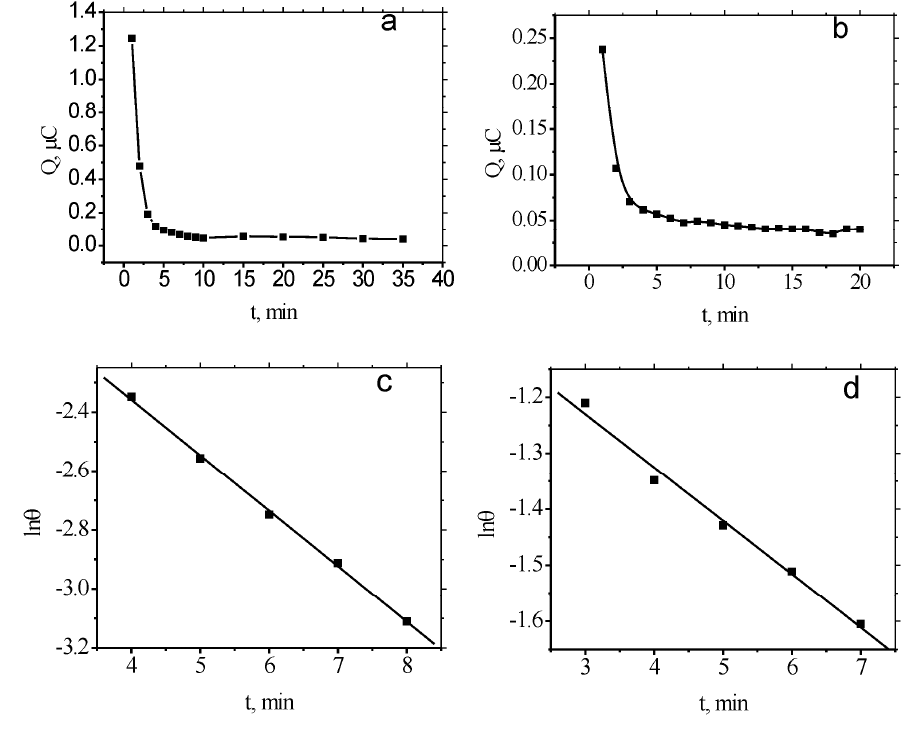
Figure 6. Integrated charge of the cathodic peaks from the CVs of ds-DNA/Au (a) and ss-DNA/Au (b) as a function of time after transfer to MB free E-buffer. Plot of ln( θ ) versus incubation time, from was determined, for ds-DNA/Au (c) and ss-DNA/Au which the first-order rate constant k d